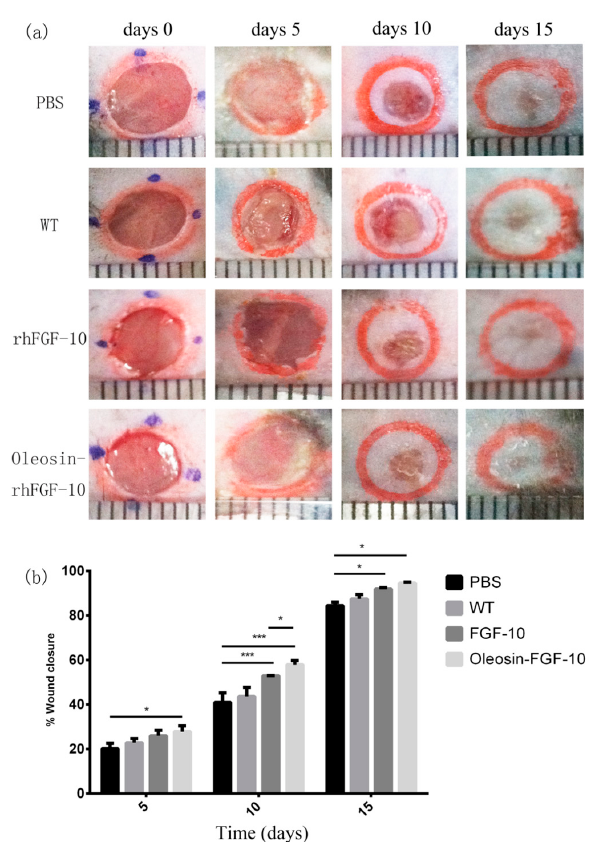
Figure 4. Oleosin-rhFGF-10 enhances wound closure. ( a ) Photographs of wounds receiving four treatments, on days 0, 5, 10 and 15. The scales shown at the bottom of each image are mm; ( b ) wound closure rates were quantified and statistically analyzed. Significant differences between the treatment groups ( n = 6) were determined. *** p < 0.001, * p < 0.05.